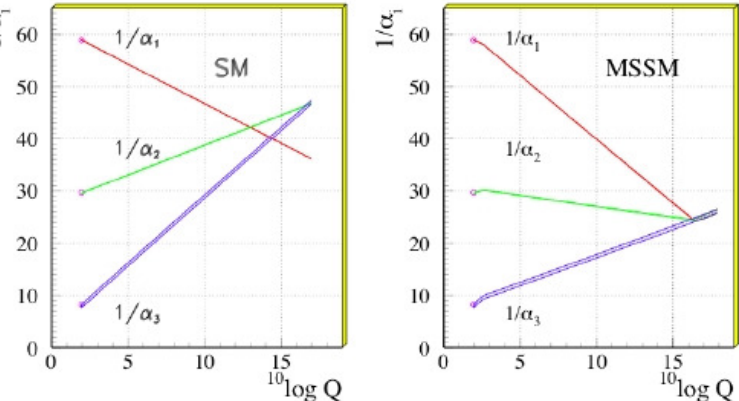
Figure 12. The couplings of the three gauge interactions in the standard model ( left ) converge at high energy, but not to the same point, whereas introducing the supersymmetric particles ( right ) helps to unite the interactions. MSSM: minimal supersymmetric standard